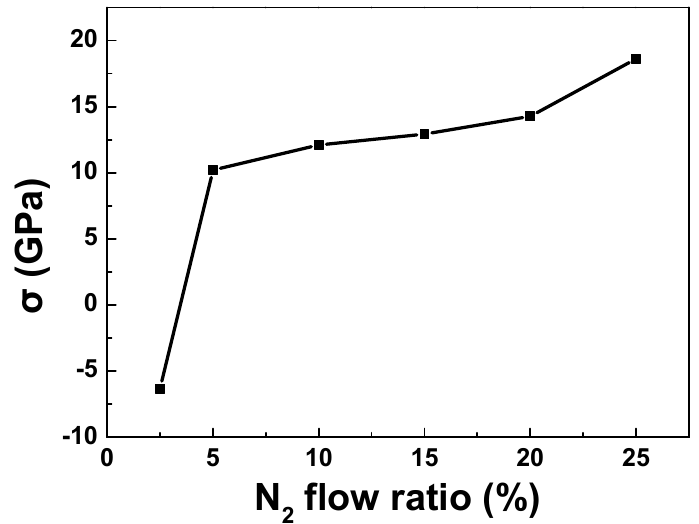
Figure 2. Plot of σ vs. N 2 flow ratio.